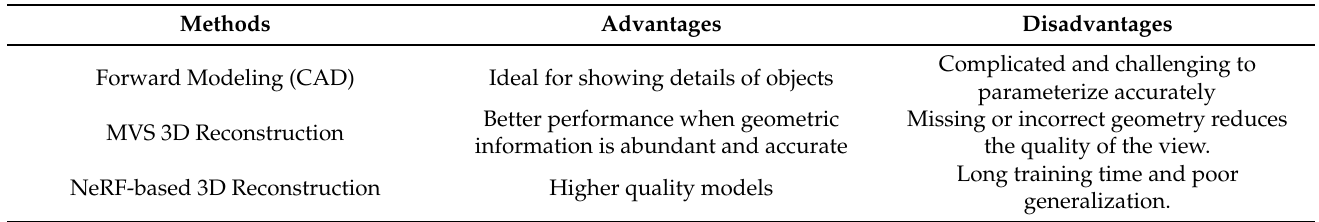
Figure 1. An overview of NeRF model presented by Ben Mildenhall et al. [25]. We create images using the sampling of 5D coordinates (location and viewing direction) along camera rays ( a ), feeding those locations into an MLP to create a color and volume density ( b ), and then utilizing volume rendering algorithms to merge these values into an image ( c ). Because of the differentiability of this rendering function, we can improve the scene representation by decreasing the difference between the synthetic and actual ground truth observed images ( d ). Table 1. Advantages and disadvantages of the mainstream 3D modeling